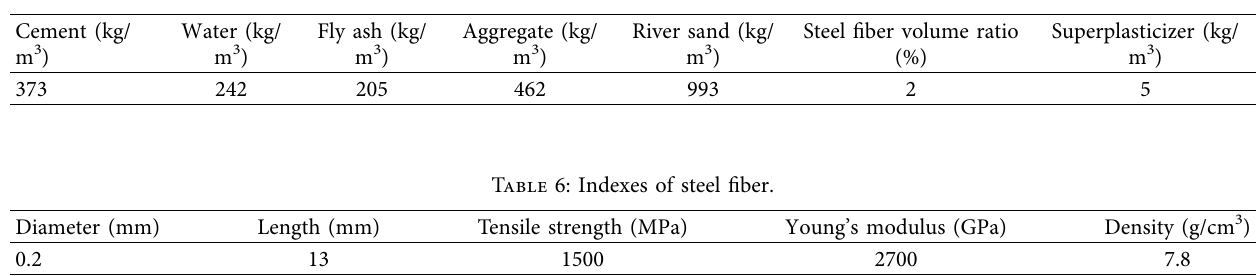
Table 5: Mixture of SFRC-FA.